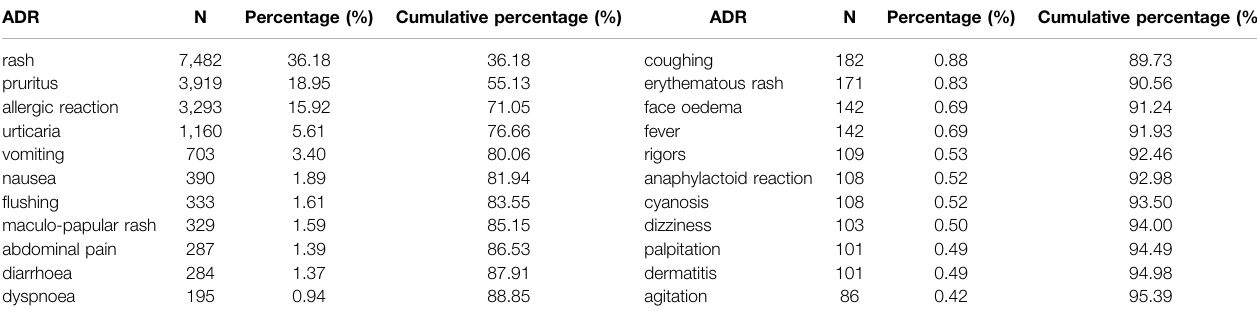
TABLE 6 | Number and proportion of ADRs ( n (cid:1) 23,377).